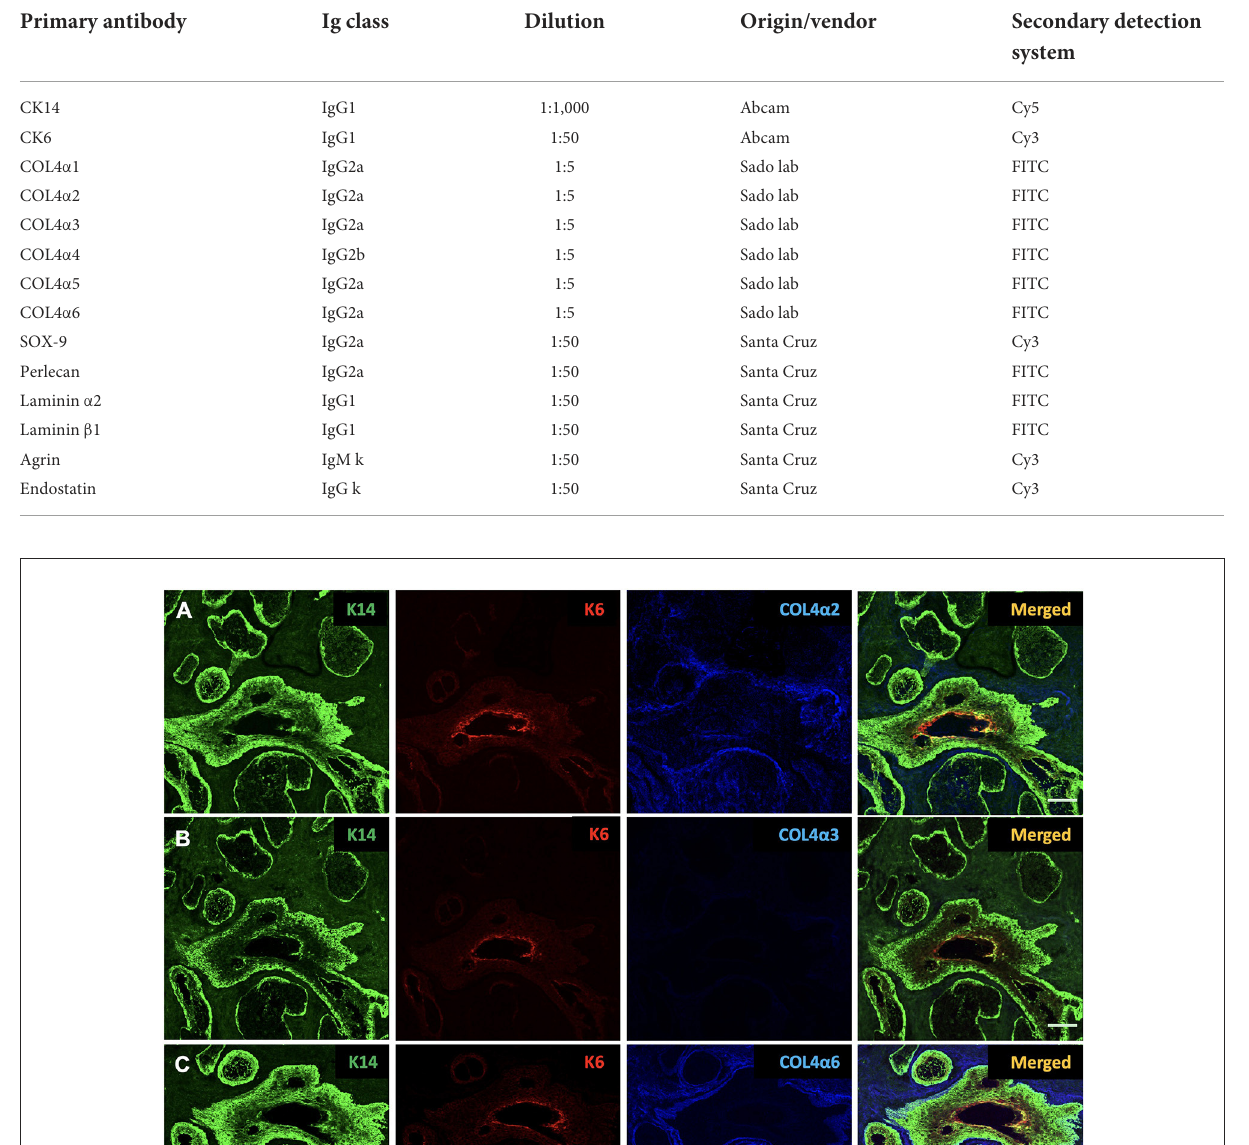
TABLE 1 List of primary antibodies used in immunolocalization of acinar and ductal cell markers and extracellular matrix components in human meibomian gland.